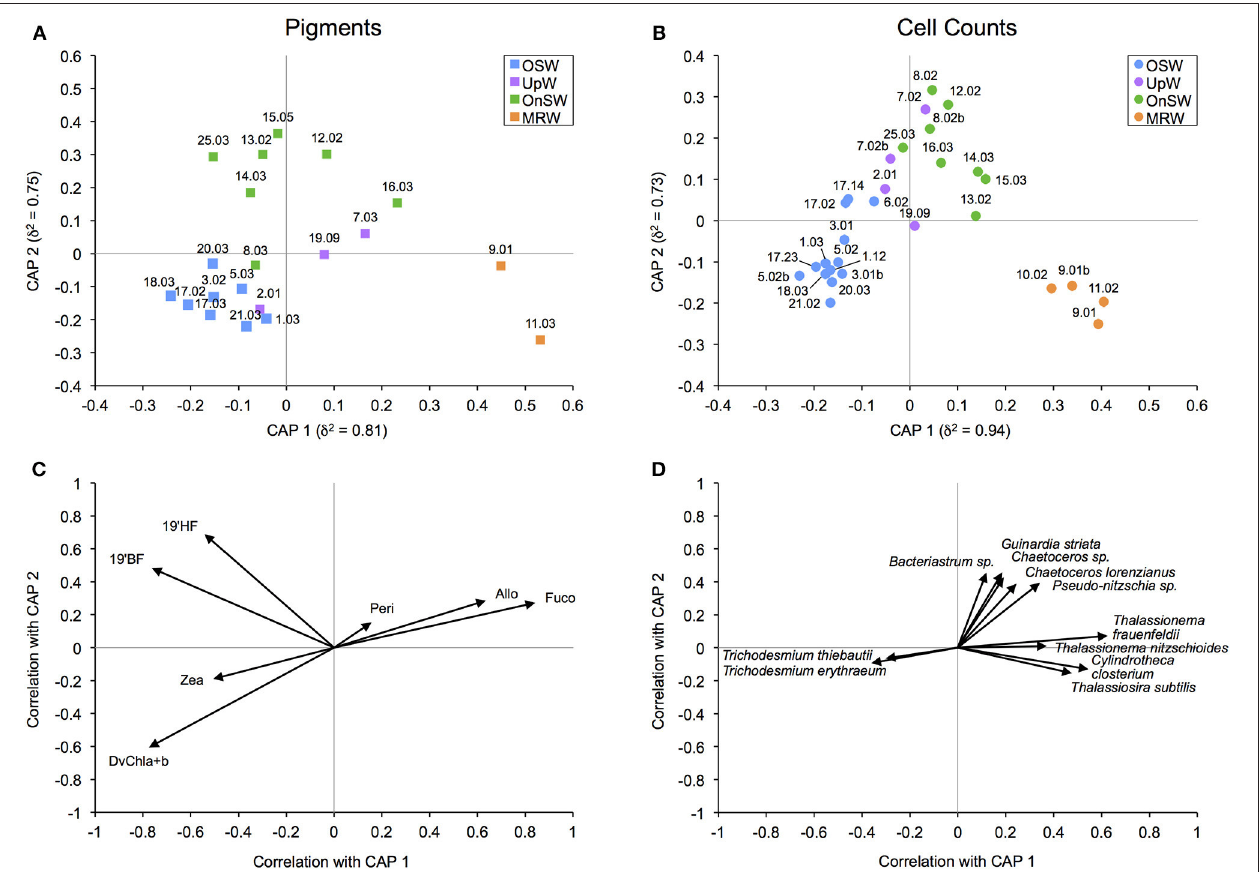
FIGURE 6 | Canonical analysis of principal coordinates (CAP) ordination for diagnostic pigment (A) and species-specific cell count (B) community data. δ 2 is the canonical correlation of a given axis. The biplots display the correlations of phytoplankton pigments (C) and species (D) with their respective canonical axes. The species plot (D) shows only the phytoplankton with a Pearson correlation of | r | ≥ 0.3 that also comprised ≥ 2% of the total abundance of the habitat with which they best correlate. For example, the four species correlating most strongly and positively with CAP 1 made up ≥ 2% of the abundance sampled at the four MRW casts. Given the poor separation of UpW from OSW and OnSW habitats (see also Table 3 ), UpW was not explicitly considered in the abundance